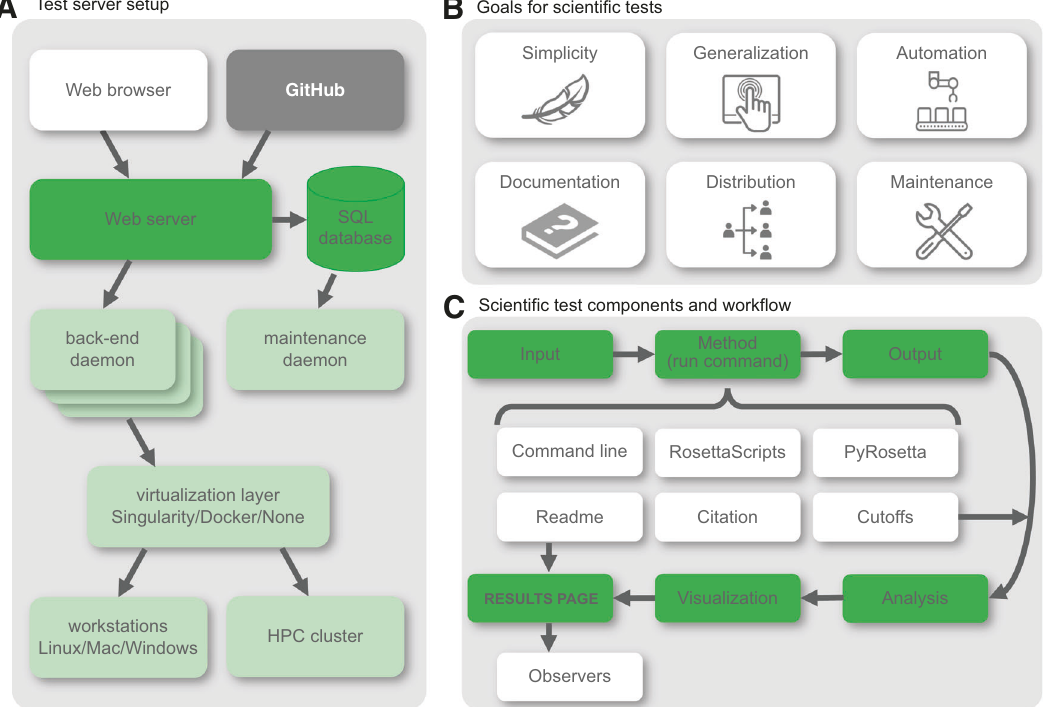
Fig. 1 Goals and setups for the scienti fi c tests. A Test server setup with the web browser as the user interface, the frontend in bright green, and the backend in light green. The code is stored in GitHub, shown in dark gray. B Speci fi c goals for our scienti fi c tests, driven by fl aws in a previous iteration of these tests. Each point is described in detail in the text. C Basic infrastructure of the scienti fi c test framework, motivated by simplicity. Each box represents a fi le, folder, or script that is either provided in the template folder or generated throughout the protocol run. The basic work fl ow is highlighted in green with components that facilitate documentation and maintenance shown in white. [Icons in Fig. 1B were created by Ana Teixeira, Aman, Ben Davis, Gregor Cresnar, Anna Sophie, and Joel Avery from Noun Project.] SQL structured query language, HPC cluster high-performance computing